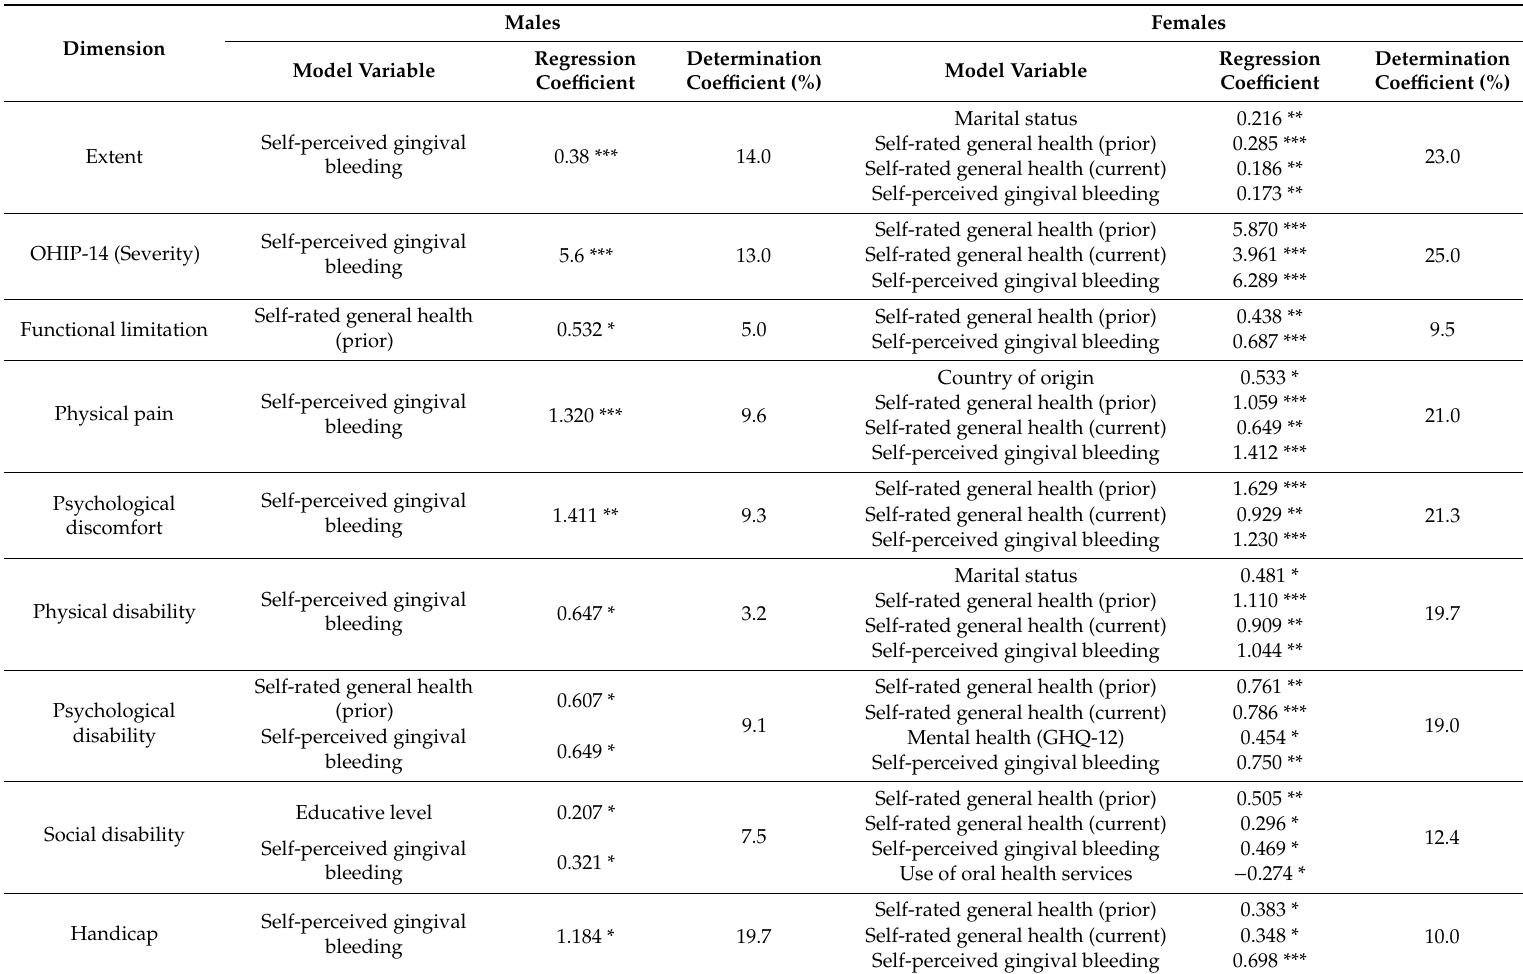
Table 5. Lineal regression models for the scores of dimensions of the OHIP-14 in the PELFI cohort, Spain (n = 401).